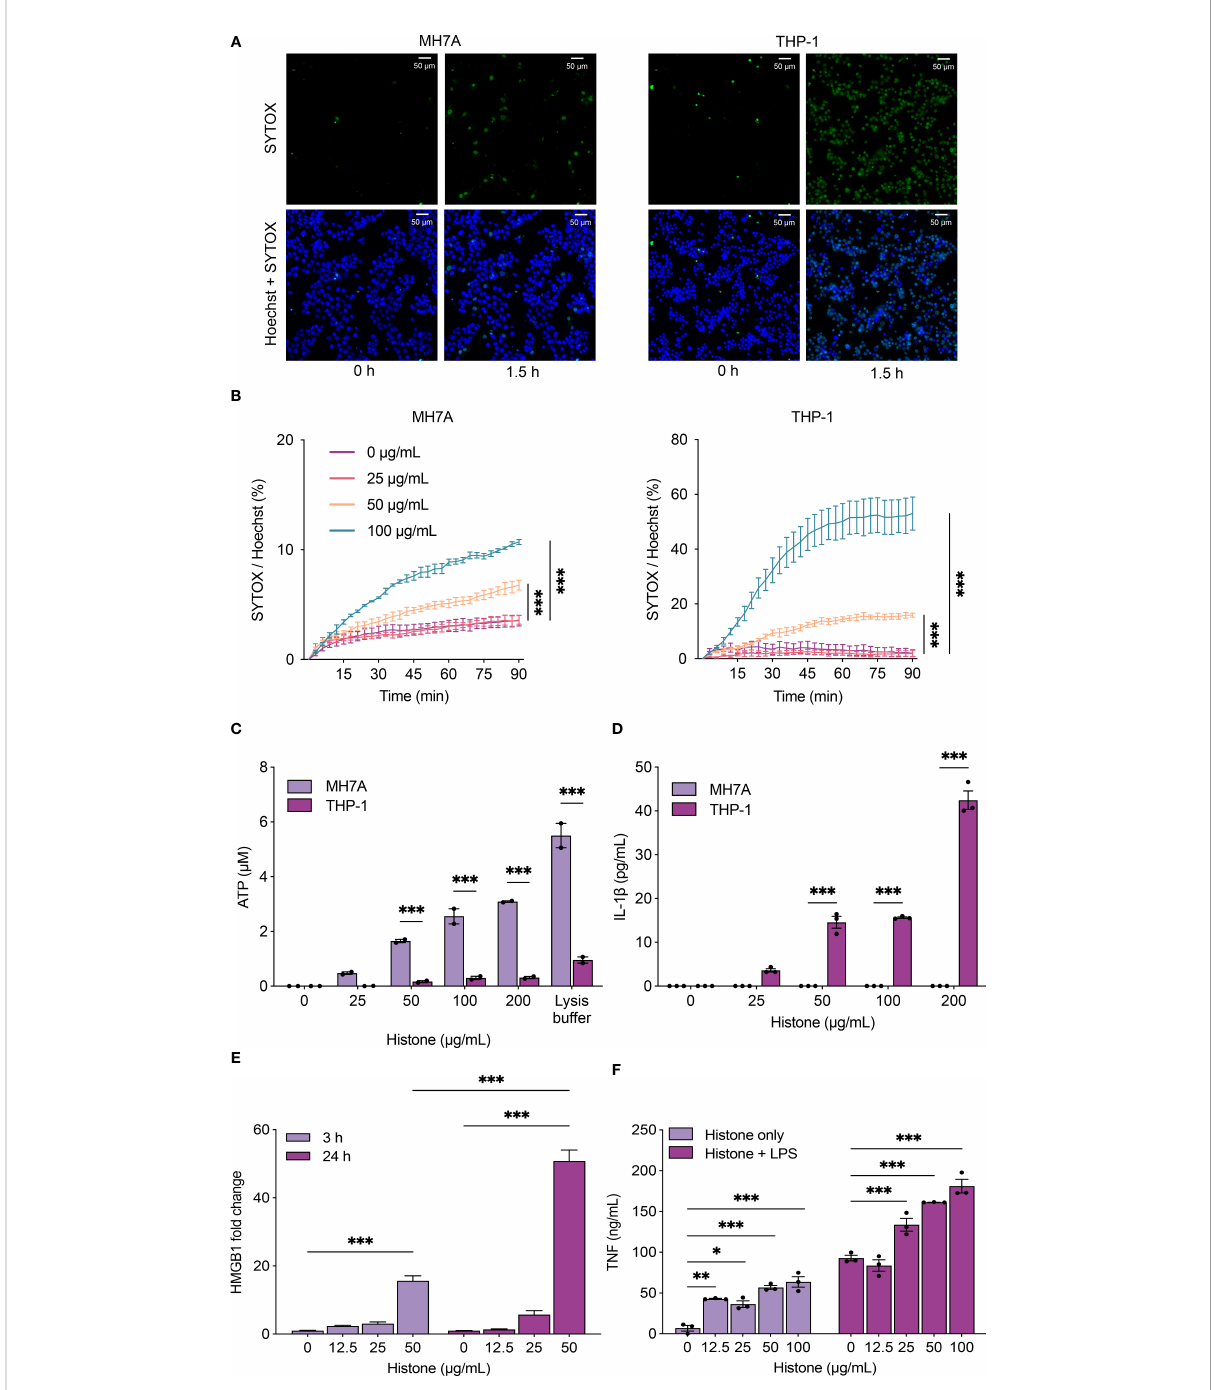
FIGURE 2 Histones induce cytotoxicity and the release of damage-associated molecular patterns (DAMPs). (A) Histone-induced cytotoxicity in MH7A and THP-1 cells detected by SYTOX Green. Representative fl uorescence microscopy images of MH7A (left) and THP-1 cells (right) with 100 m g/mL of histones. See also Supplement Movies 1A, B (B) Time-course plot of dead cells detected by SYTOX green with the Operetta cell imaging system, MH7A (left) and THP-1 cells (right). (C) Levels of extracellular ATP from MH7A and THP-1 cells treated with histones for 1 h. (D) Levels of extracellular IL-1 b from MH7A and THP-1 cells treated with histones for 1 h. (E) Levels of HMGB1 from THP-1 cells treated with histones for 3 h or 24 h. (F) Levels of TNF- a from THP-1 cells treated with histones and/or lipopolysaccharides (LPS; 10 ng/mL) for 24 h. Data are expressed as the mean ± standard error of the mean. ANOVA with Tukey – Kramer multiple comparison tests were conducted. * P < 0.05, ** P < 0.01, and *** P < 0.001. The experiments were performed with technical replicates of three wells per